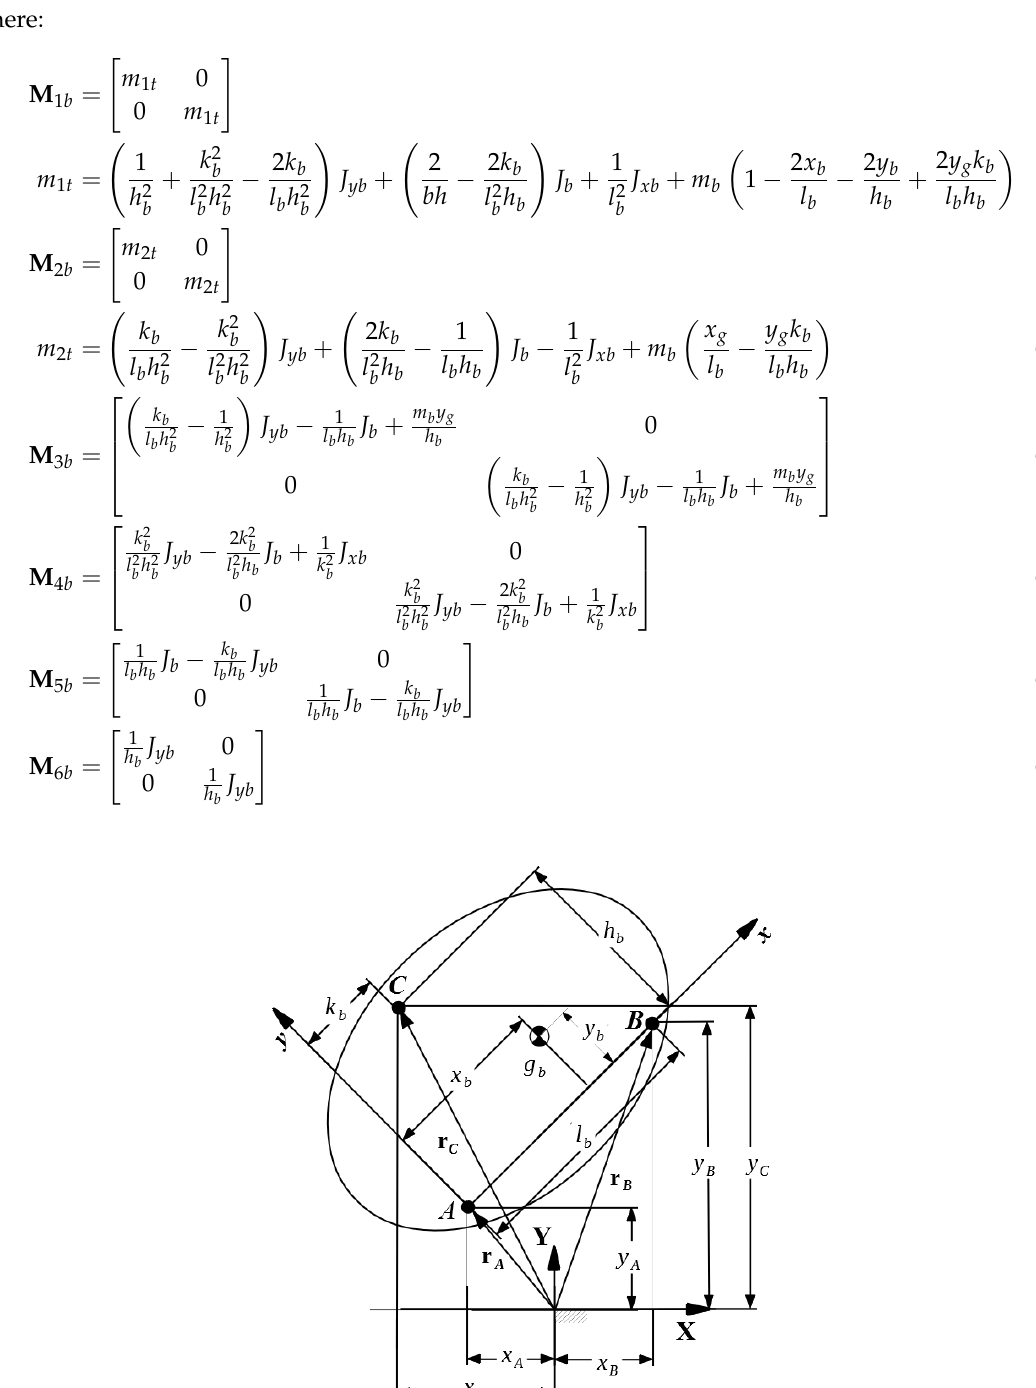
Figure 2. A model of a body in fully Cartesian Coordinates using three basic points: A , B , and C